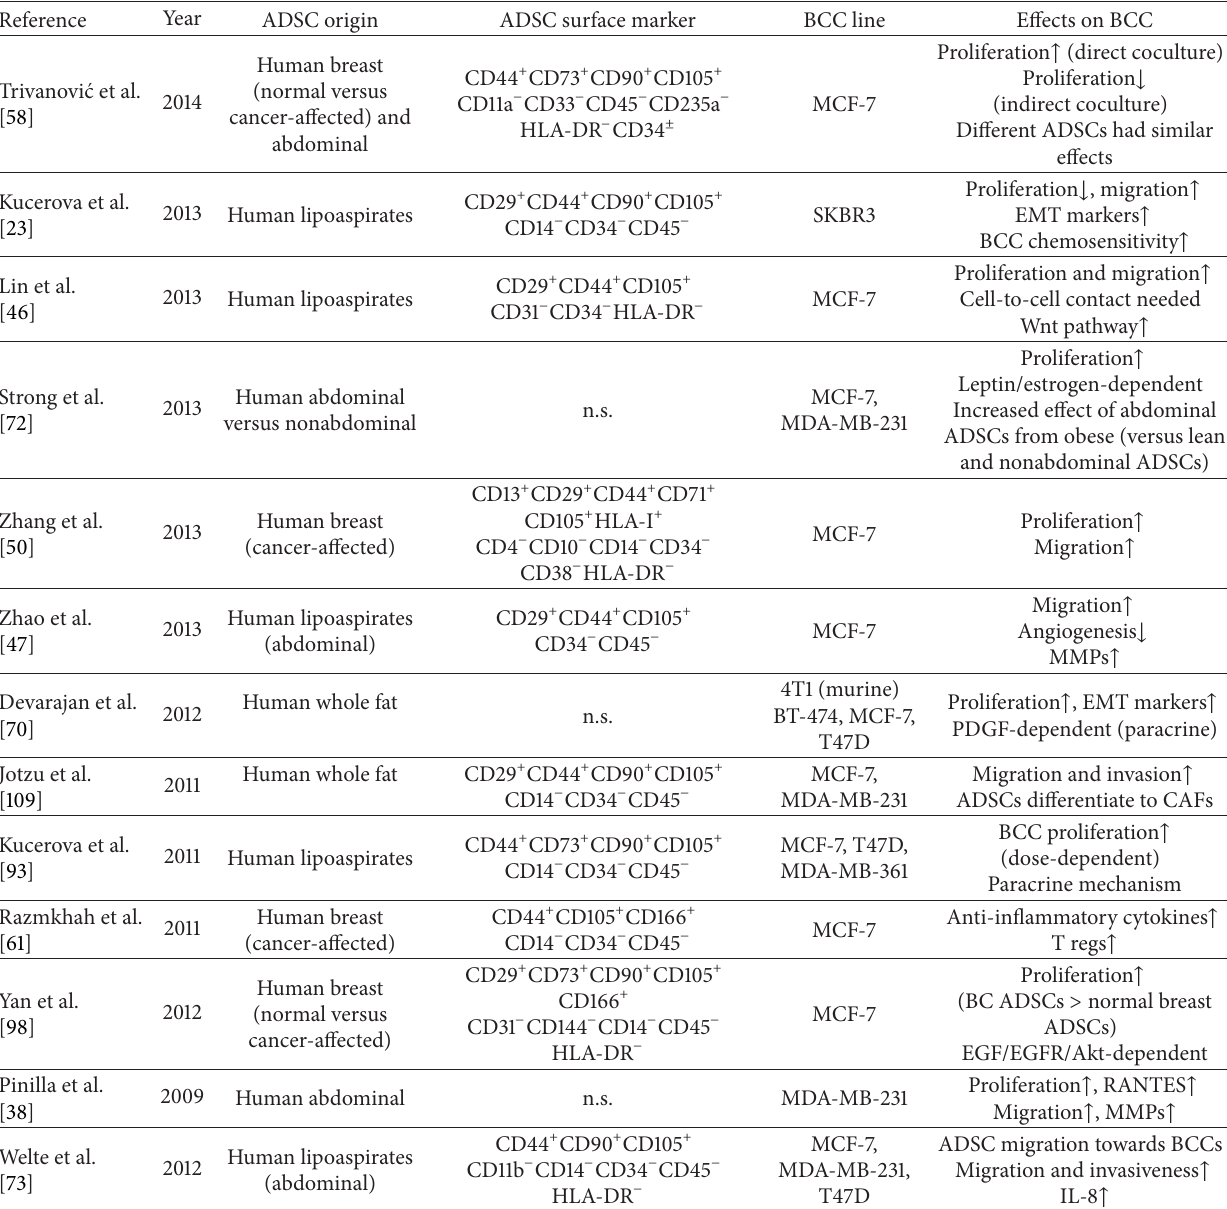
Table 2: Relevant in vitro studies investigating the effects of ADSCs on breast